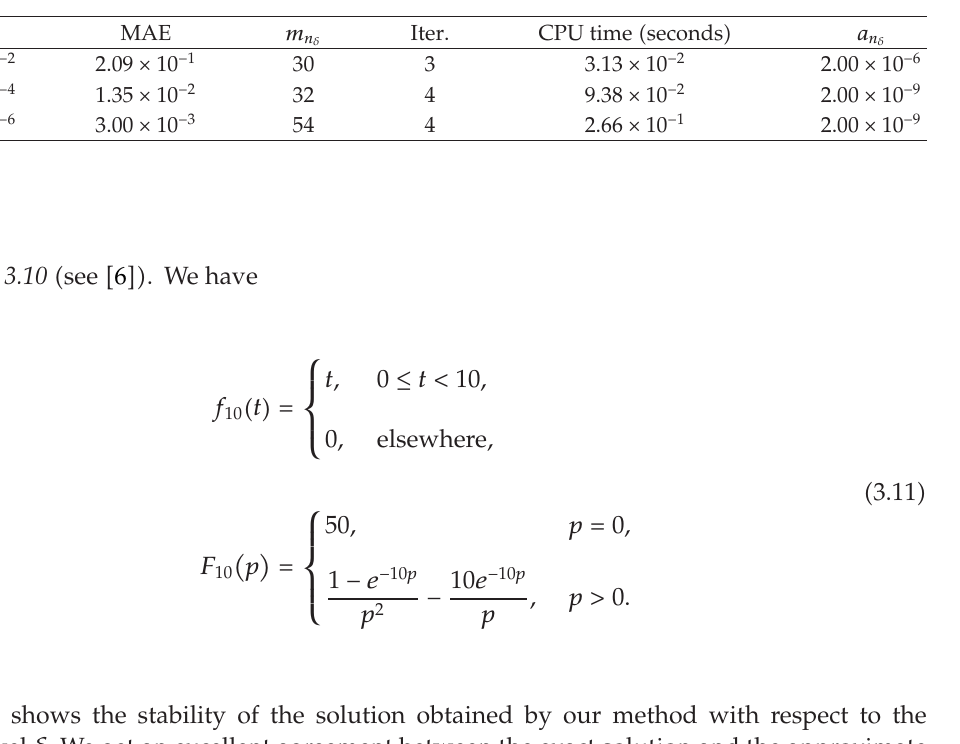
Table 10: Example